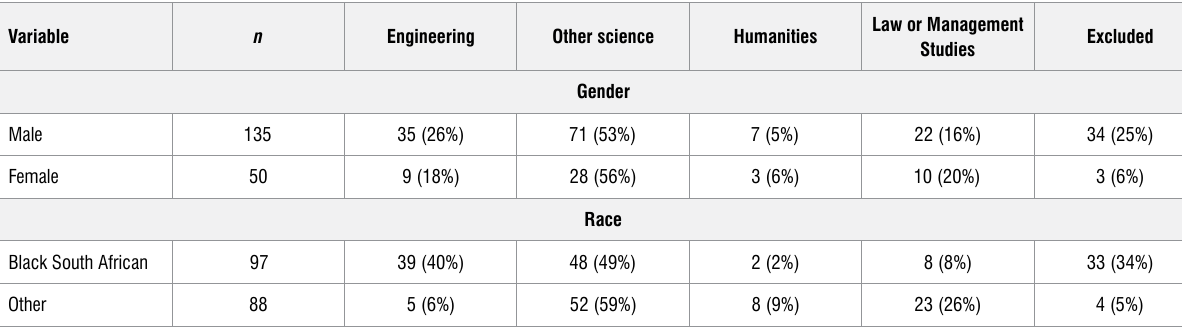
Table 4: Destinations of the students who switched from the engineering major ( n =185)